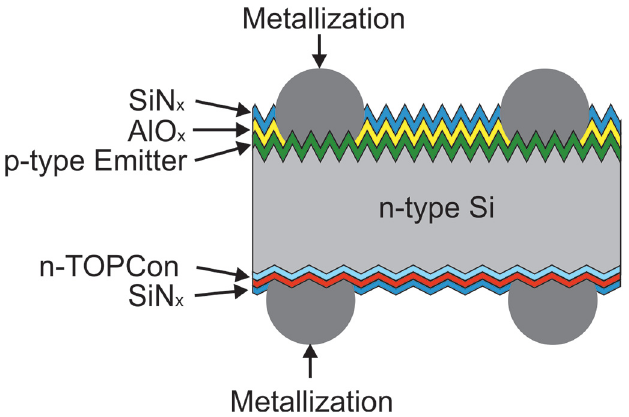
Fig. 1. Schematic of a metallized bifacial TOPCon solar cell.